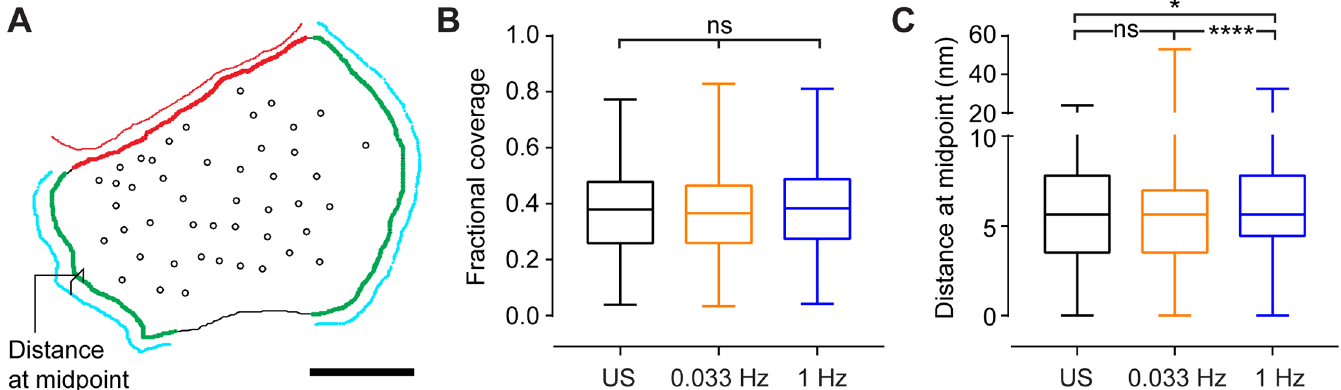
Fig 5. Glial coverage of presynaptic terminals. A) Reconstruction of the terminal from coordinates on EM image. Black line is presynaptic terminal perimeter. Red line is postsynaptic density. Cyan lines are glial process membranes. Red and green highlighting on terminal perimeter show presynaptic active zone and extrasynaptic glial-facing membrane respectively. Scale bar = 100 nm. B) Box and whisker (min to max) plot of fractional coverage of terminal by glial membrane (length of green highlights/terminal perimeter). C) Box and whisker plot of distance between glial process and glial facing membrane (cyan line and green highlight) at midpoint along glial facing membrane length. Synapses typically have 2 or 3 glial facing regions per terminal. For unstimulated slices, n = 431 glial membranes from 166 terminals; for 0.033 Hz stimulation, n = 806 glial membranes from 295 terminals; for 1 Hz stimulation, n = 801 glial membranes from 287 terminals. Statistical comparisons: ns p > 0.05, (cid:3) p = 0.0232, (cid:3)(cid:3)(cid:3)(cid:3) p < 0.0001 Kruskal-Wallis ANOVA test with Dunn’s correction for multiple comparisons.